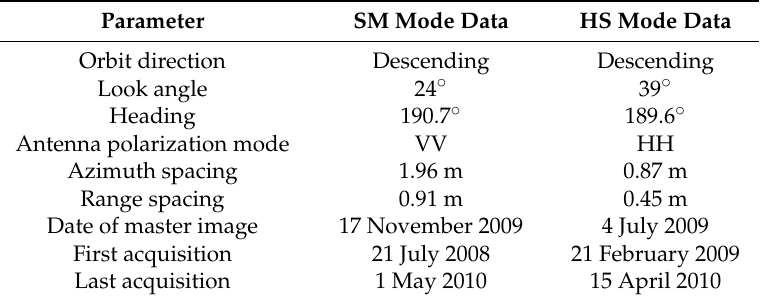
Table 1. Basic parameters about the TerraSAR-X images.